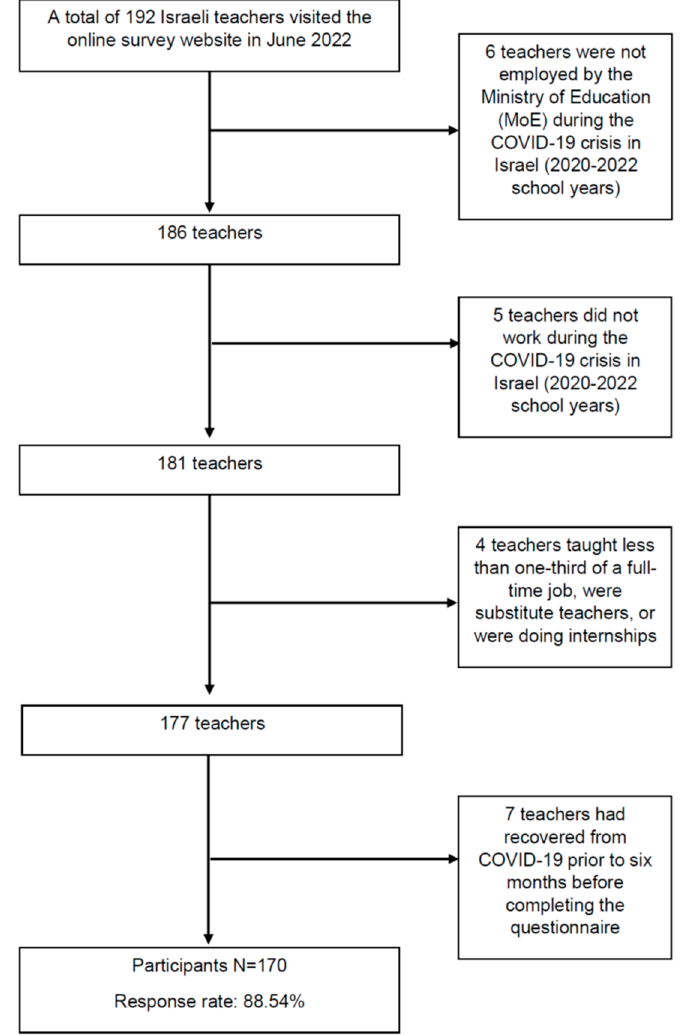
Figure 1. Flowchart of inclusion of participants in the study.